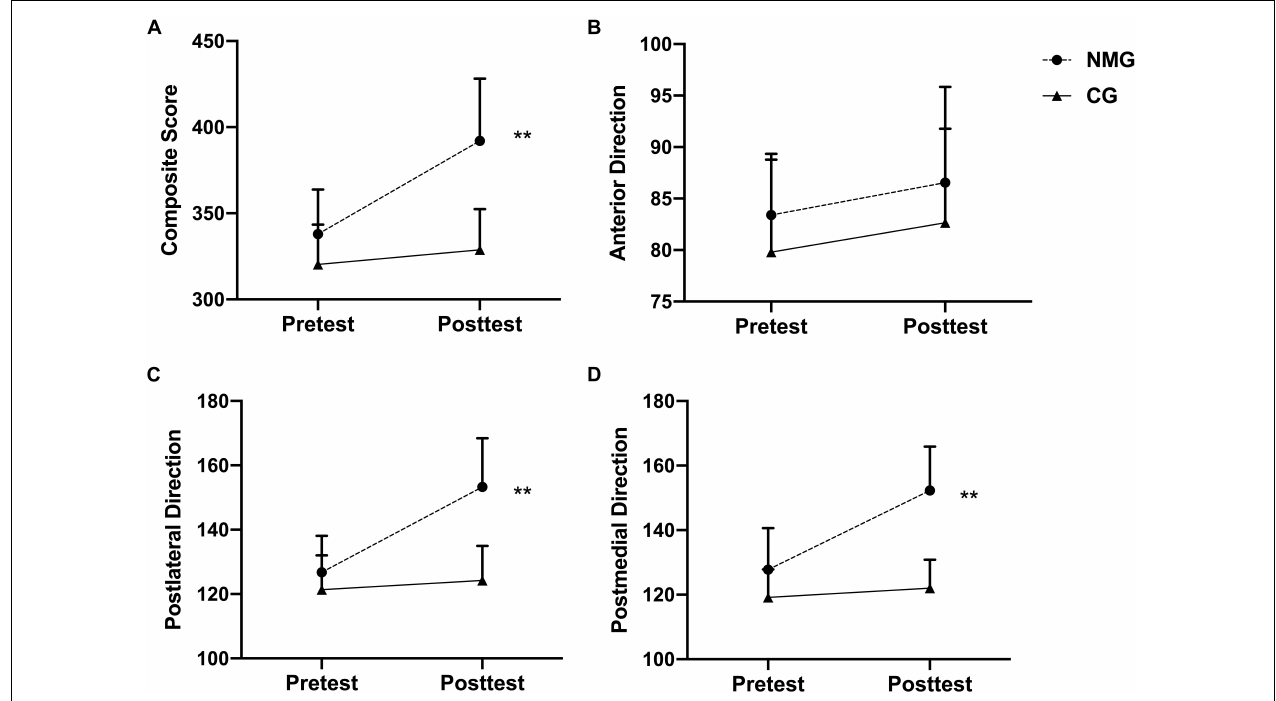
FIGURE 2 | Changes in the Composite (A) , the anterior- (B) , posterolateral- (C) , and posteromedial- (D) direction Y-balance test score on right limb in the neuromuscular training group (NMT) and the control group (CG) before and after the program (**inter group difference with p ≤